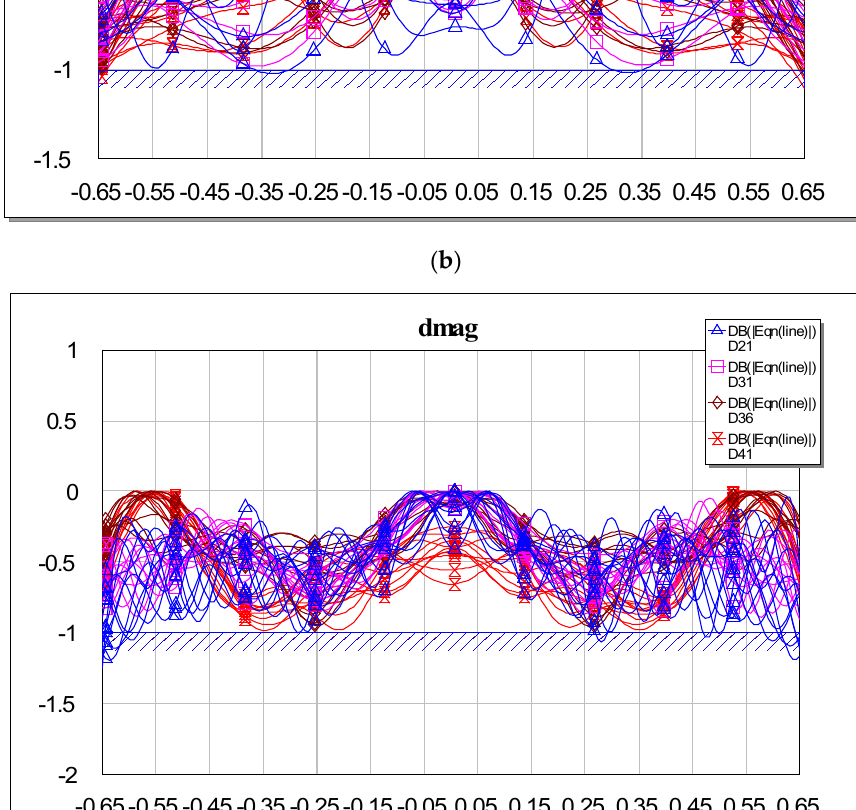
Figure 12. Amplitude variation of composite pattern fields at different frequency points on observation lines at different distances (2 m, 2.5 m, 3 m and 3.5 m). ( a ) 700 MHz–2.0 GHz. ( b ) 2.0–3.0 GHz. ( c ) 3.0–4.0 GHz.